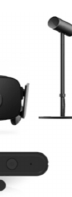
Figure 1. Peripheral hardware of the Virtual Reality Hand Controllers (VR-HC) system.